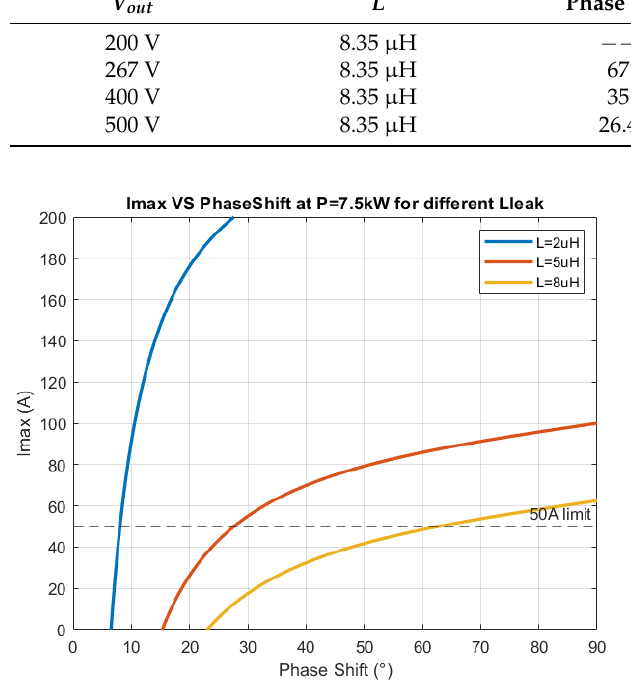
Figure 4. I max vs. phase shift at maximum power for different leakage inductances.